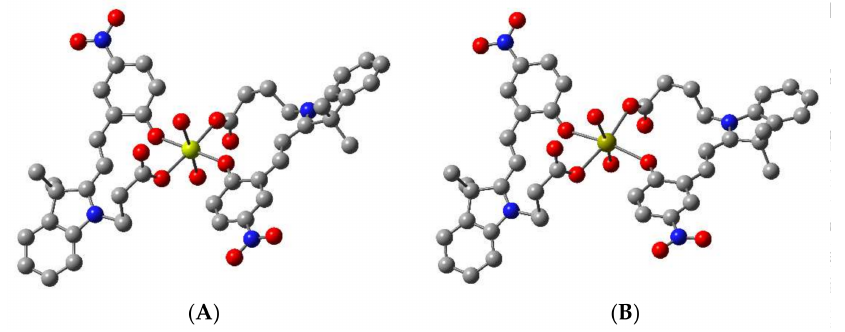
Figure 2. B3LYP/6-311G** optimised structure of 1 bound to ( A ) Mg 2+ (yellow) and ( B ) Ca 2+ (gold), respectively, in a 2:1 ratio, showing oxygen atoms (red) chelating to the metal ion. Hydrogen atoms are omitted for